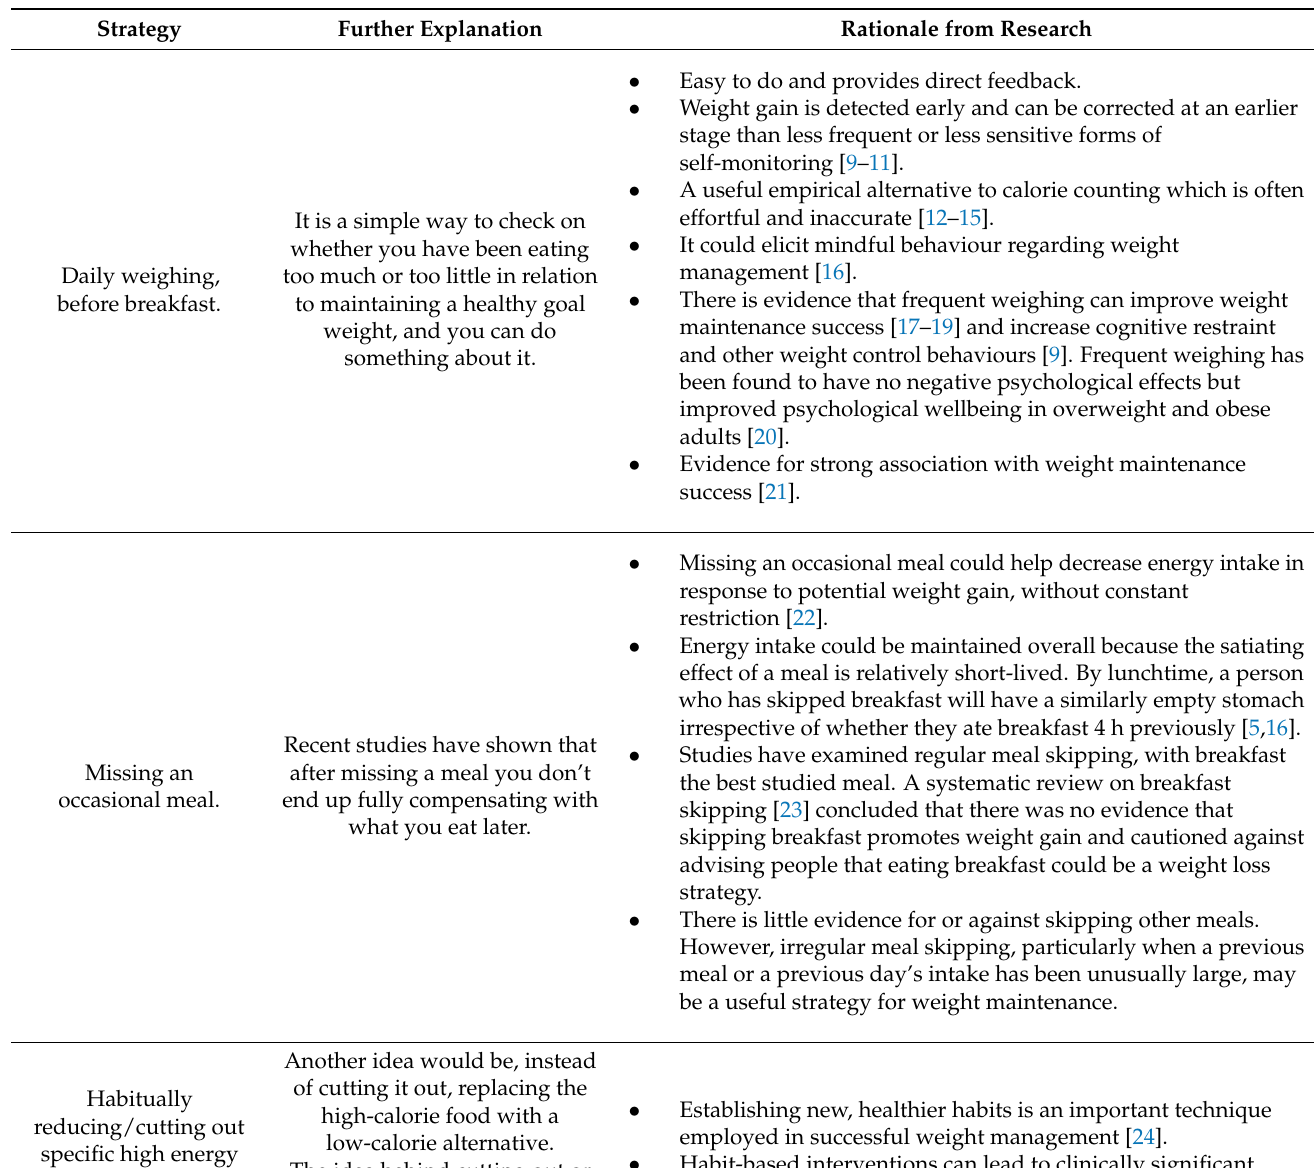
Table 1. Selected strategies for weight